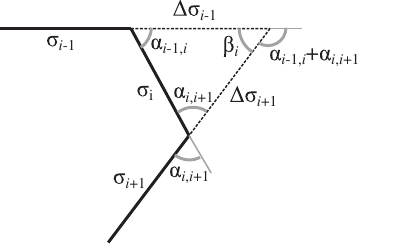
FIG. 13. Portion of the force polygon for the hub vertex considered during the induction. Force balance at the hub vertex is equivalent to the closure of the force polygon. Each edge in the figure is a vector parallel to the spoke edges whose length is equal to the magnitude of the stress component in that edge. Here, we show only the forces along spokes i − 1 , i , i þ 1 and how they change if spoke i were to be